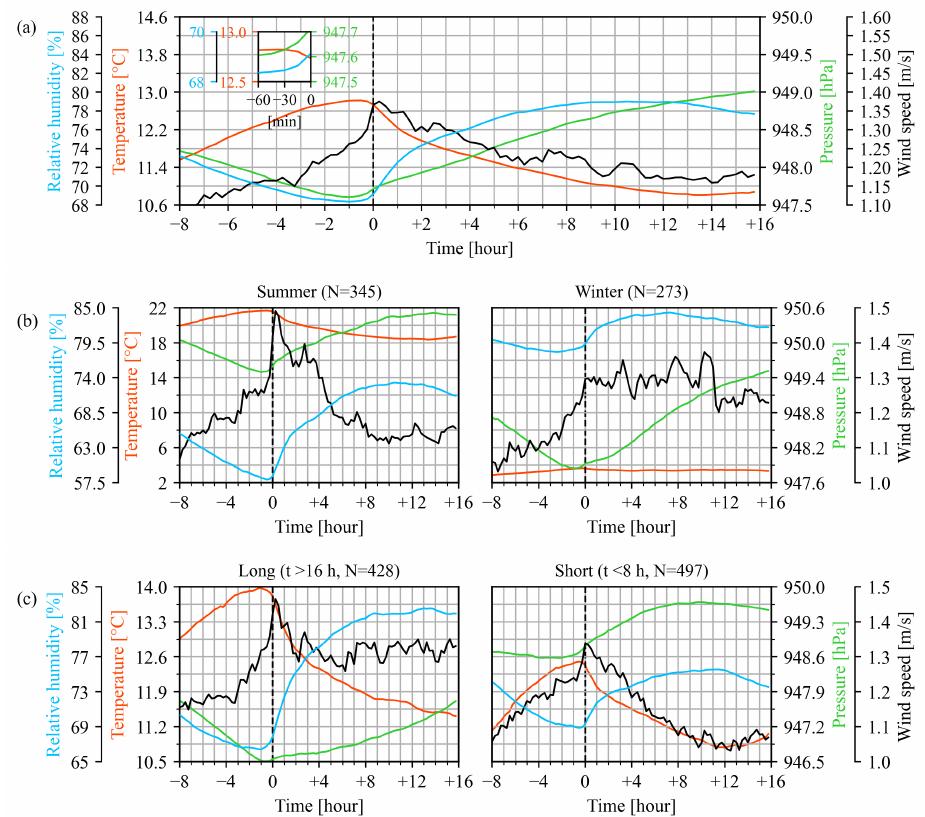
Figure 3. Composites of ( a ) temperature (red solid line), pressure (green solid line), relative humidity (blue solid line), and wind speed (black solid line) 8 h before and 16 h during rain, considering the rain events ( b ) in summer and winter, as well as ( c ) with long and short duration. Subplot ( a ) is from 60 min before rain to the onset of